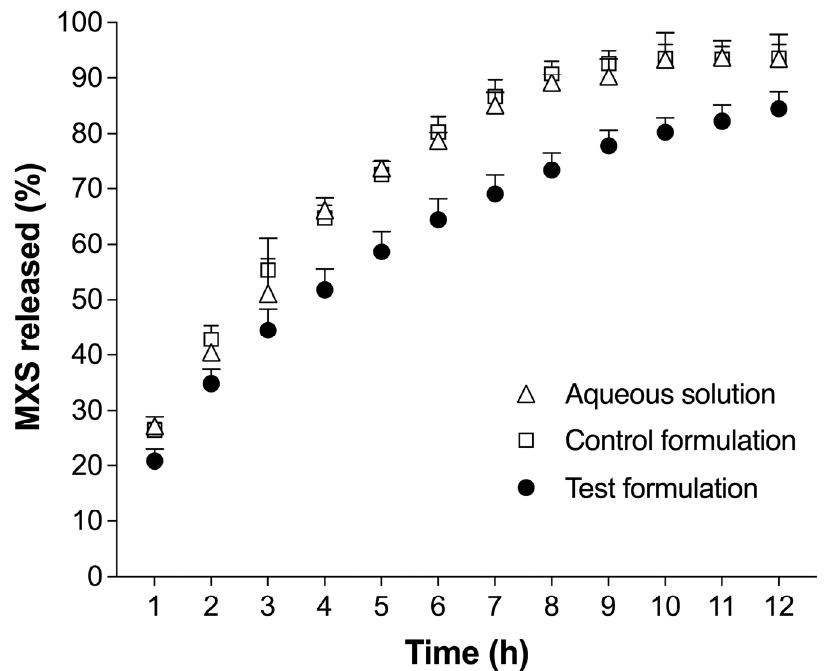
Figure 1. Release profile from test formulation (PLX 16% HPMC 0.4%), control formulation (PLX 4% HPMC 0.7%), and aqueous solution, all containing MXS 2%. Data were expressed as mean ± standard deviation (SD) of 6 replicates for each formulation ( p > 0.05).